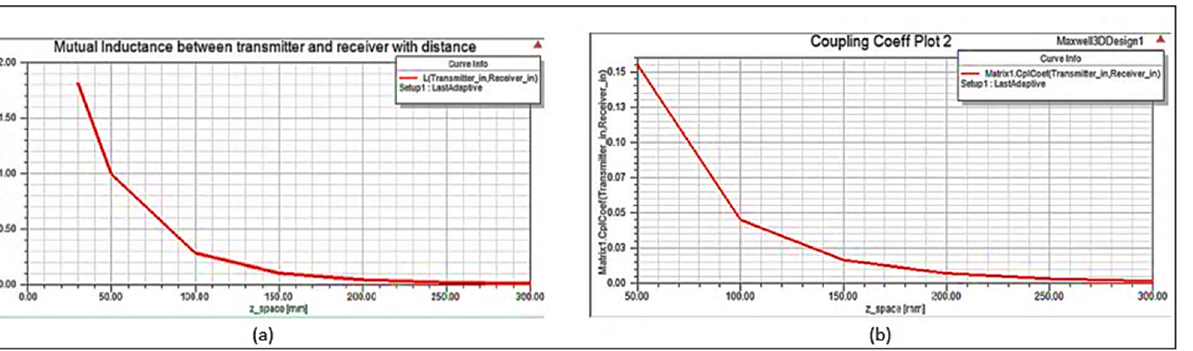
Figure 9. Results for 600 mm spiral coil: ( a ) mutual inductance vs. air gap spacing (mm), ( b ) coupling coefficient vs. air gap spacing (mm). ( a )